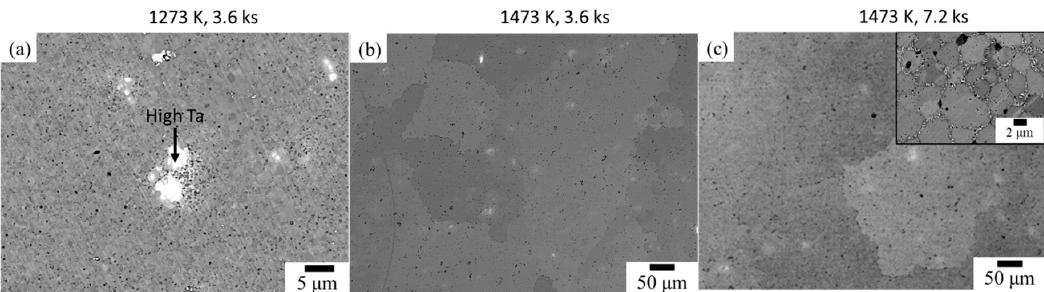
Figure 7. BSE micrographs of the TiNbZrHfTa refractory high entropy alloy (RHEA) compacts prepared by the hydride process, at; ( a ) 1273 K, 3.6 ks, ( b ) 1473 K, 3.6 ks, and ( c ) 1473 K, 7.2 ks. Table 7. Chemical analysis (wt.%) of the alloy compacts prepared by the hydride process.